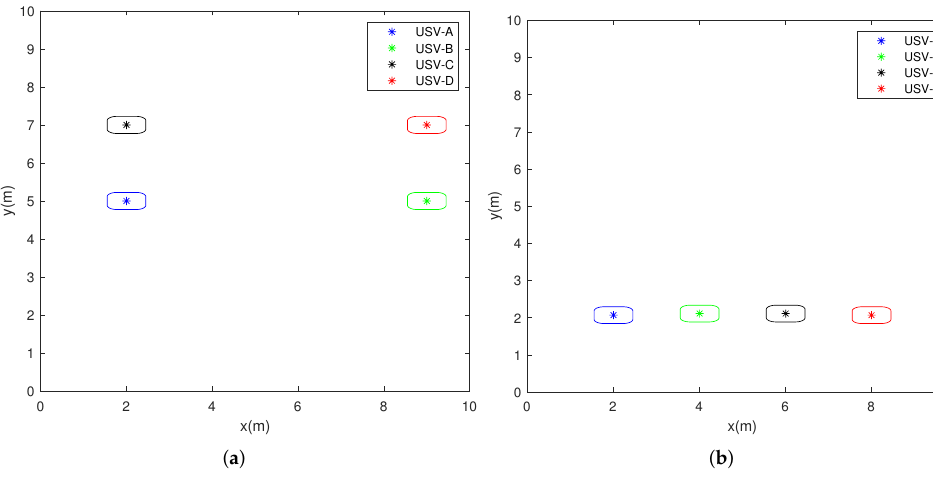
Figure 6. Initial position ( a ) and formation position ( b ) of USVs.